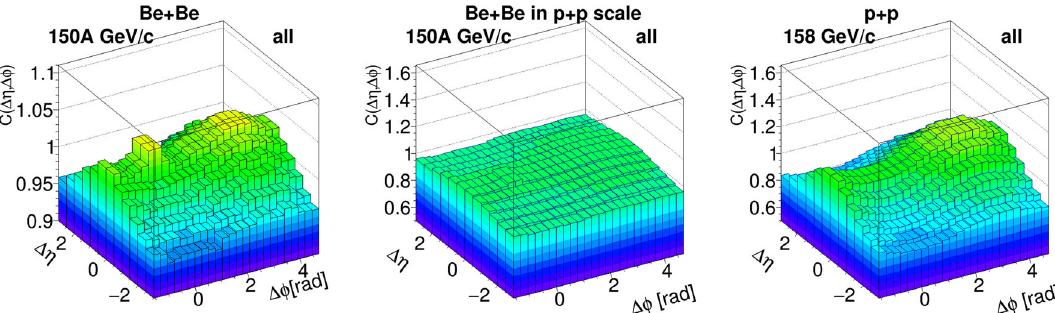
Be + Be correlation function, but shown in the vertical scale used for p + p interactions. Right column: p + p correlation function for all pairs at beam momentum 158 GeV / c taken from Ref.